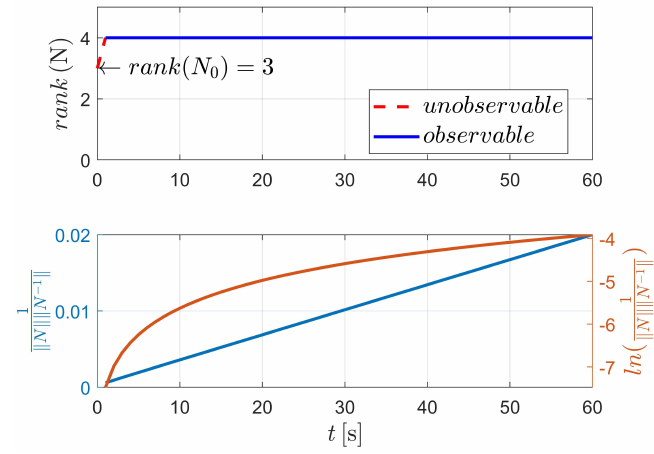
Figure 3. Observability simulation of case I (nonperturbation).